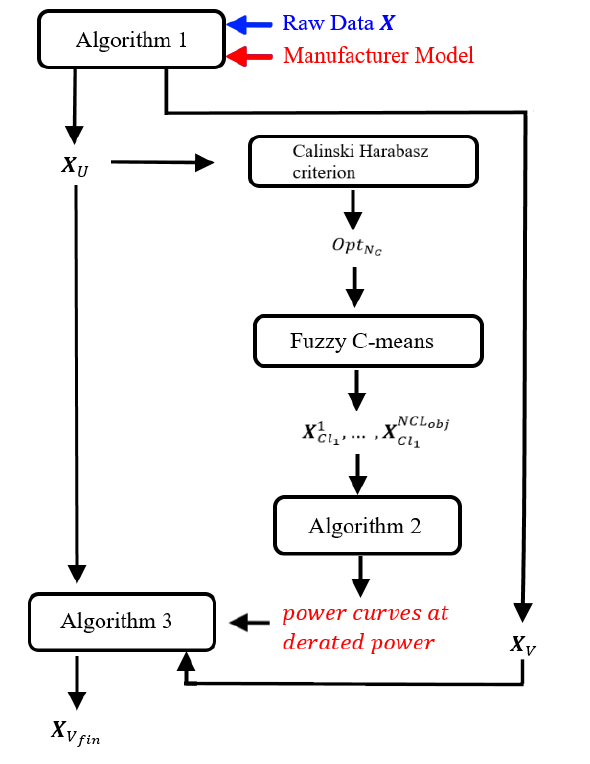
Figure 1. Proposed Methodology